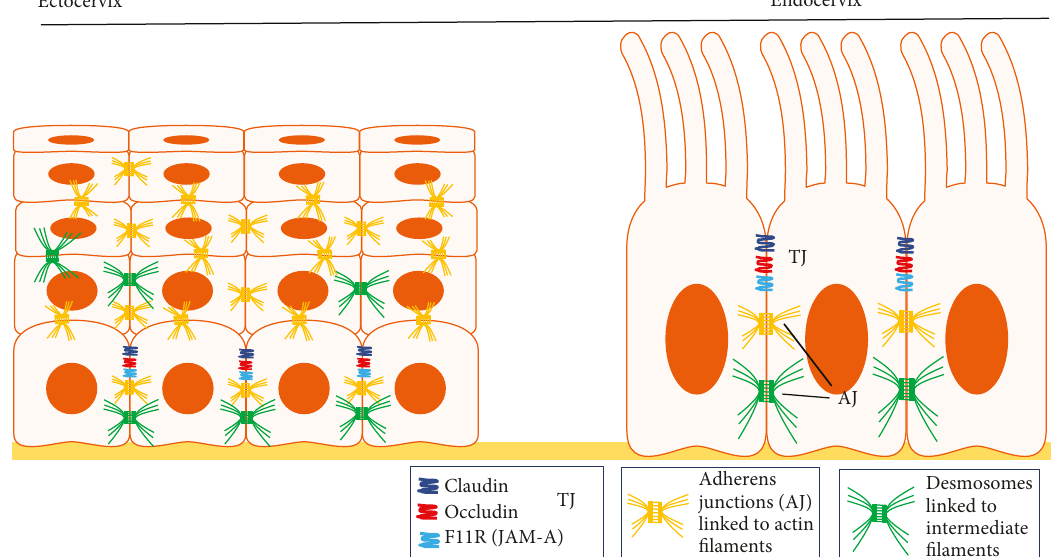
Figure 3: Pro fi le of intercellular junctions in the cervix. This fi gure shows the pro fi le and intercellular localization of interepithelial adhesion molecules in the ecto- and endocervix. The most “ potent ” junctions in the strati fi ed squamous epithelium of the ectocervix (and vagina), namely, adherens junctions (AJ), are located in the parabasal layer, just above the basal layer. As epithelial cells transition toward the apical surface, the junctions get “ more loose. ” In contrast, endocervical epithelia contain tight junctions (TJ) located close to the apical surface and AJ just below the TJ. Desmosomes are the most basal